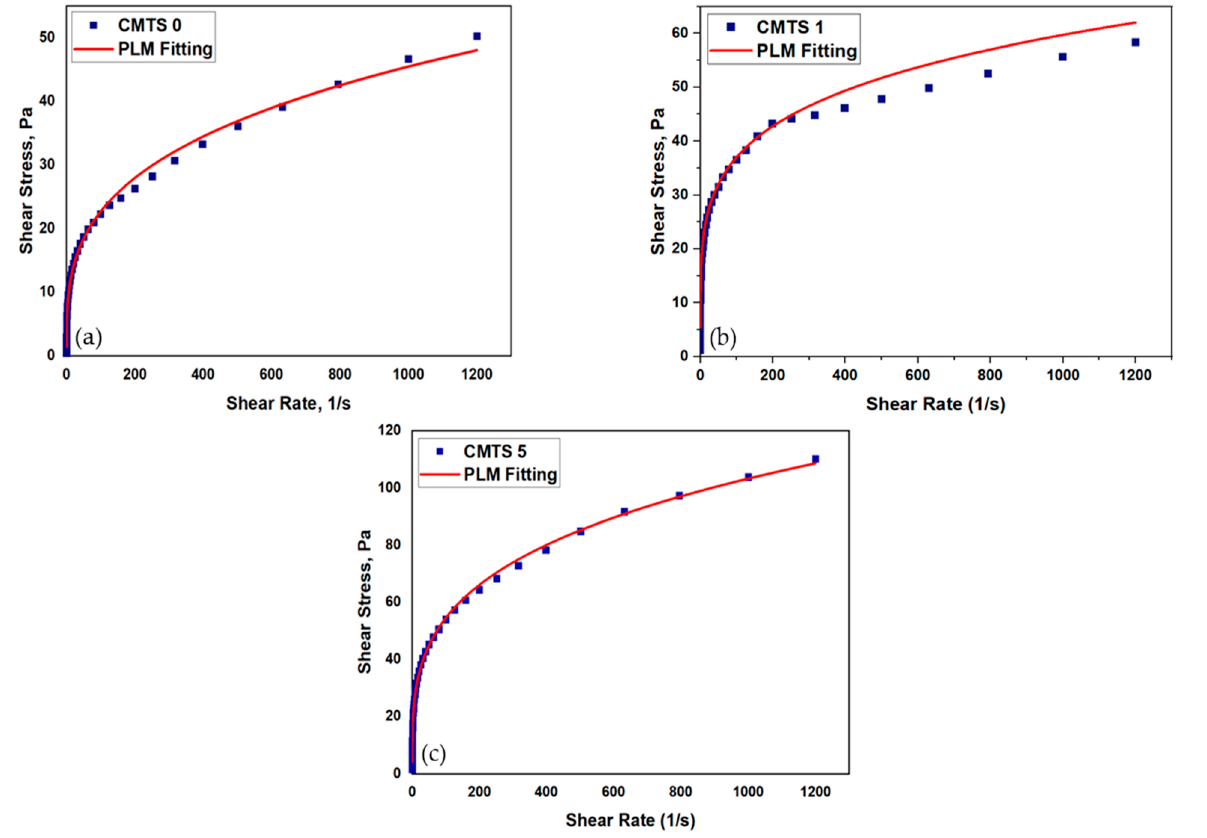
Figure 5. Rheograms of ( a ) CMTS 0, ( b ) CMTS 1, and ( c ) CMTS 5 mud sample. Table 4. Rheological Modeling Parameters.